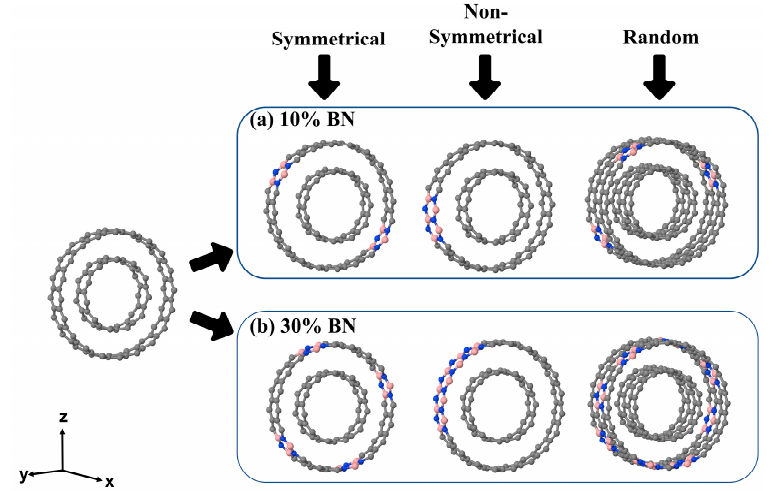
Figure 1. Unit cell of the double-wall zigzag (11,0)@(20,0) carbon nanotube. The pristine model in the left panel (44@80 atoms) and the corresponding BN-doped structures, C@ ( BN) 1 − x C x , are shown in the upper right, x = 0.10, and lower, x = 0.30, panels, respectively, for the three different patterns. In the case of the random pattern, to preserve periodicity along x, the cell must be double. Color of the atoms: gray-carbon, blue-nitrogen and pink-boron. For comparison, single-wall nanotubes (20,0) (BN) 1 − x C x , were also generated and characterized, with x covering the same concentration range as in the outer wall of the corresponding double-wall system (see Figure 2).